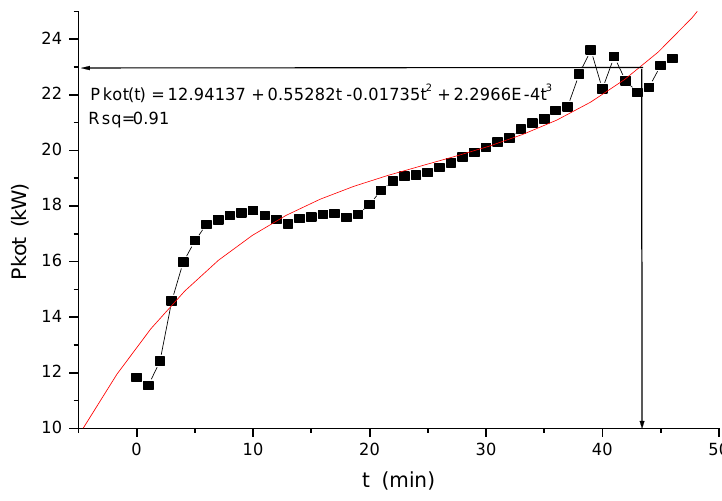
Figure 10. Dependence of Not on operation time.